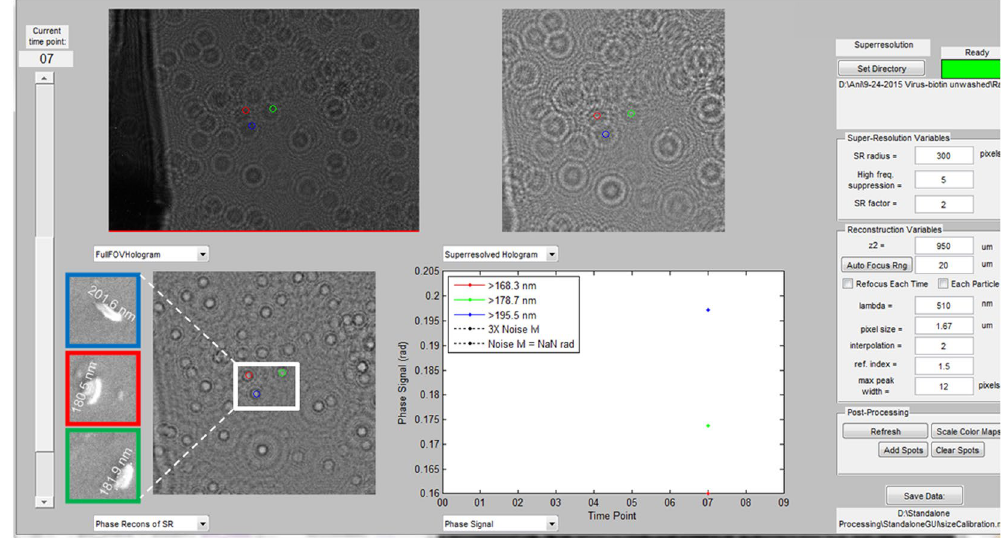
Figure 5. GUI used to reconstruct the holograms of HSV-1 particles and size them. Insets: SEM images of some of the HSV-1 particles, used for comparison purposes. The colors indicate the corresponding viral